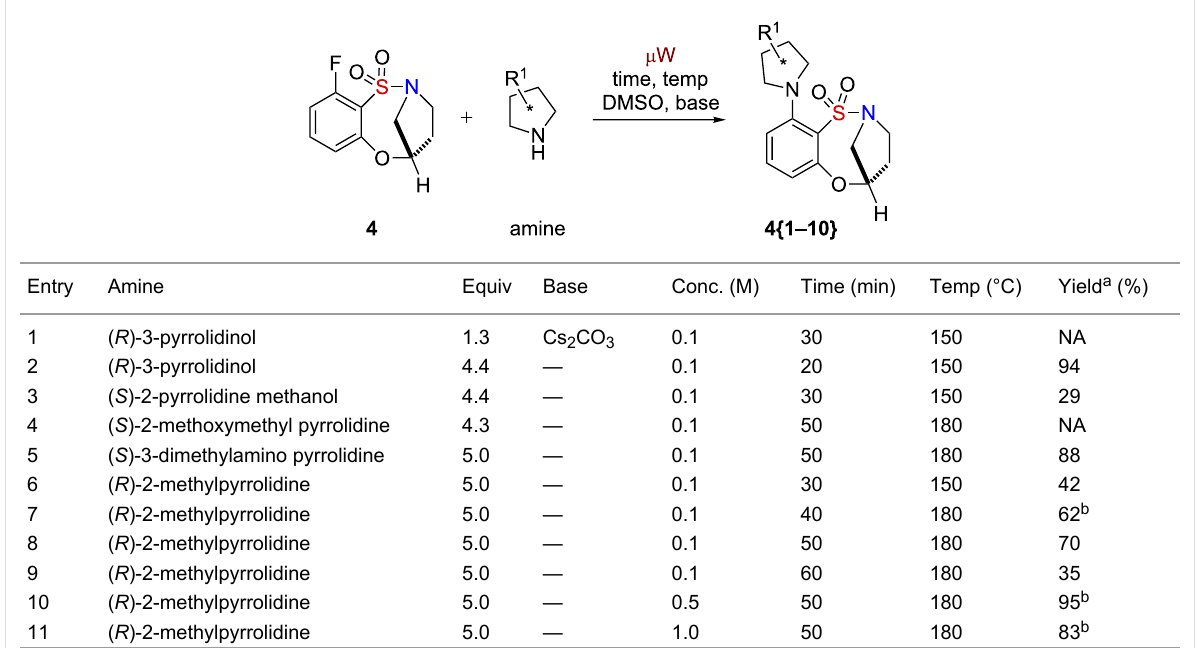
Table 1: Optimization studies for the S N Ar reaction utilizing sultam 4 .